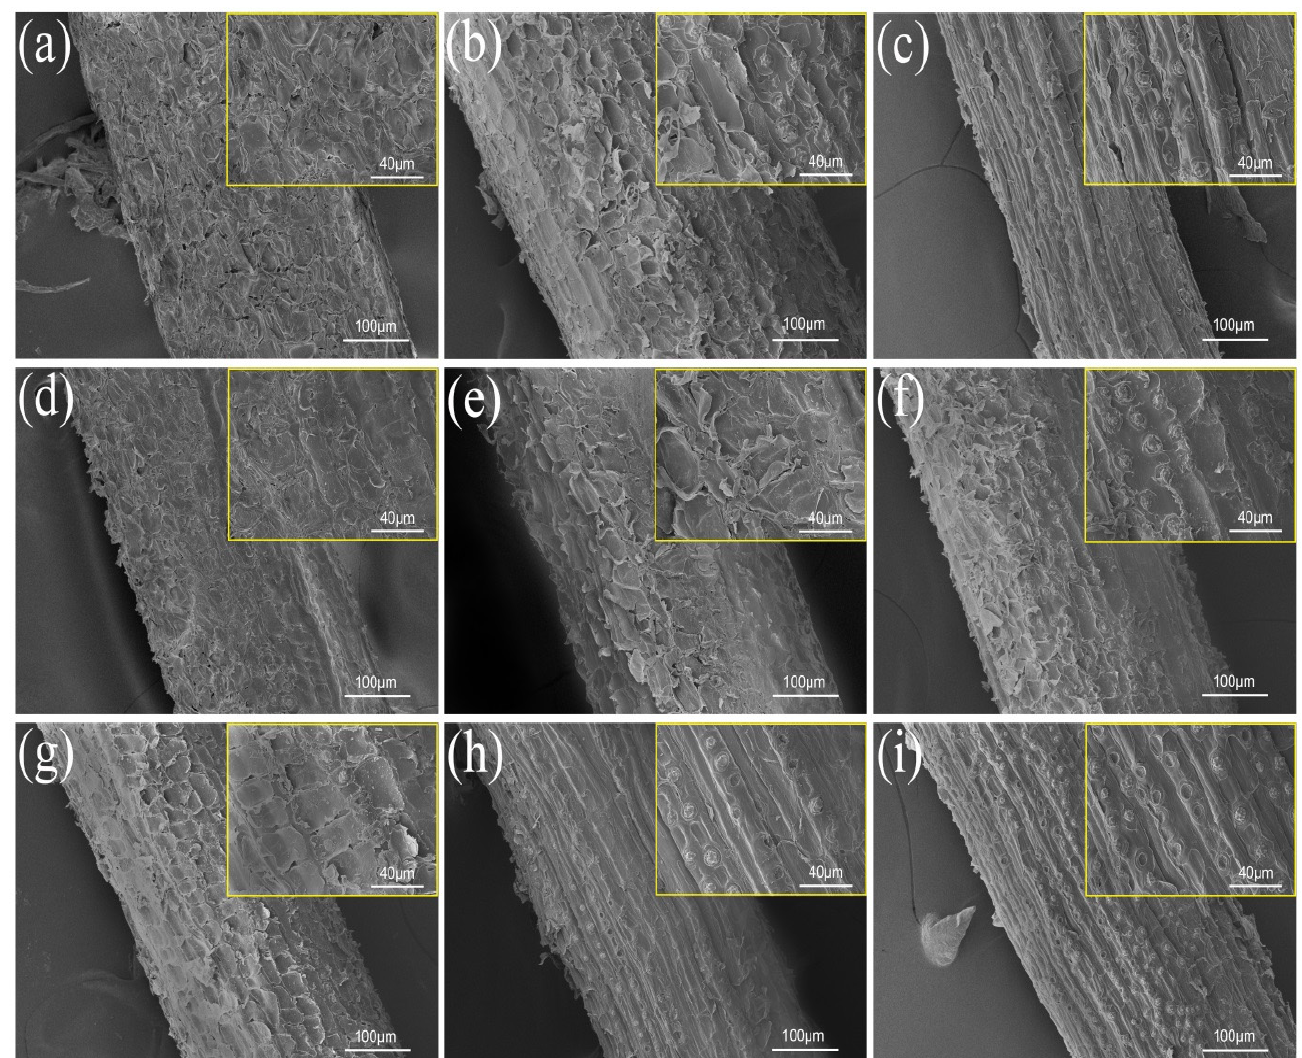
Figure 4. SEM micrographs of coir fibers: ( a ) U-CF, ( b ) M-CF, ( c ) A-CF, ( d ) AA-CF, ( e ) S-CF, ( f ) M-AA-CF, ( g ) M-S-CF, ( h ) A-AA-CF, ( i ) A-S-CF.